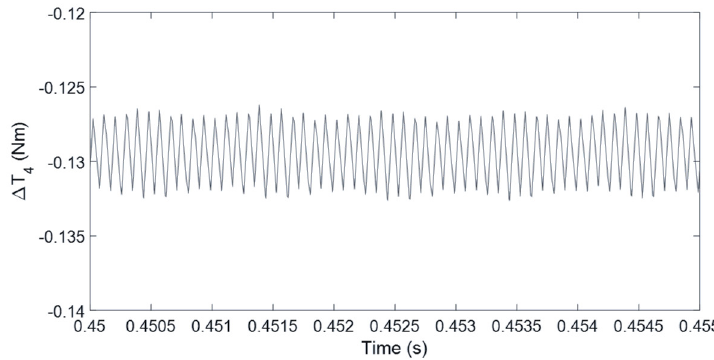
Figure 18. The fourth torque variation term for cSVM-DTC1.